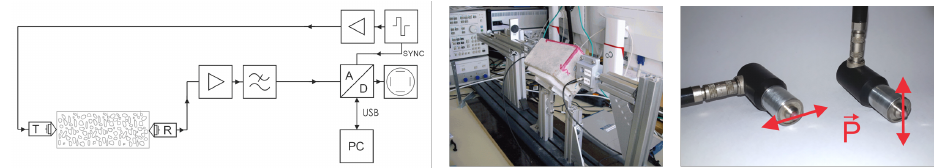
Figure 6. Ultrasonic measuring system: block diagram ( left ), photo of the measurement set-up ( centre ) and close-up, of the ultrasonic probes ( right ). In the close-up the polarization (cid:126) P of the transmitters is shown in